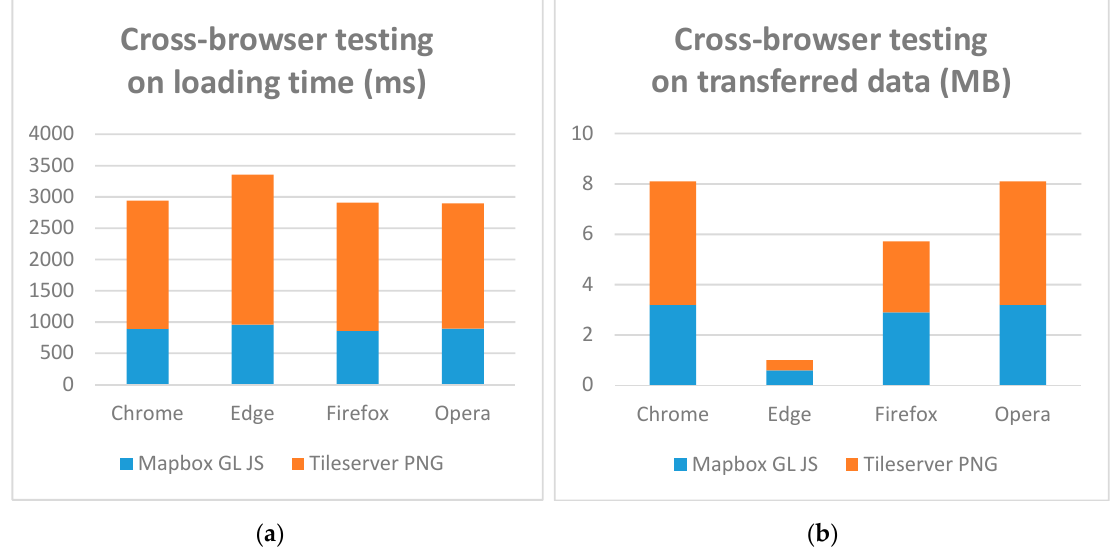
Figure 12. Results of cross-browser testing: loading time ( a ); transferred data ( b ). Note: Capturing of transferred data via Edge is not comparable, see below.